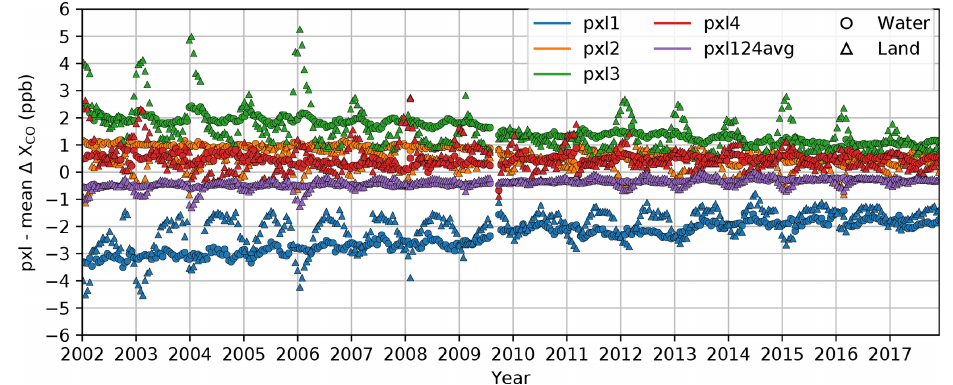
Figure 2. Pixel (pxl) biases compared to the weighted mean with time. Data are averaged into 15d bins separated for land and water soundings. The mean of pixels 1, 2, and 4 is also shown because pixel-3 data are not included in the L3 product. The small gap in 2009 is from a temporary cooler malfunction on 28